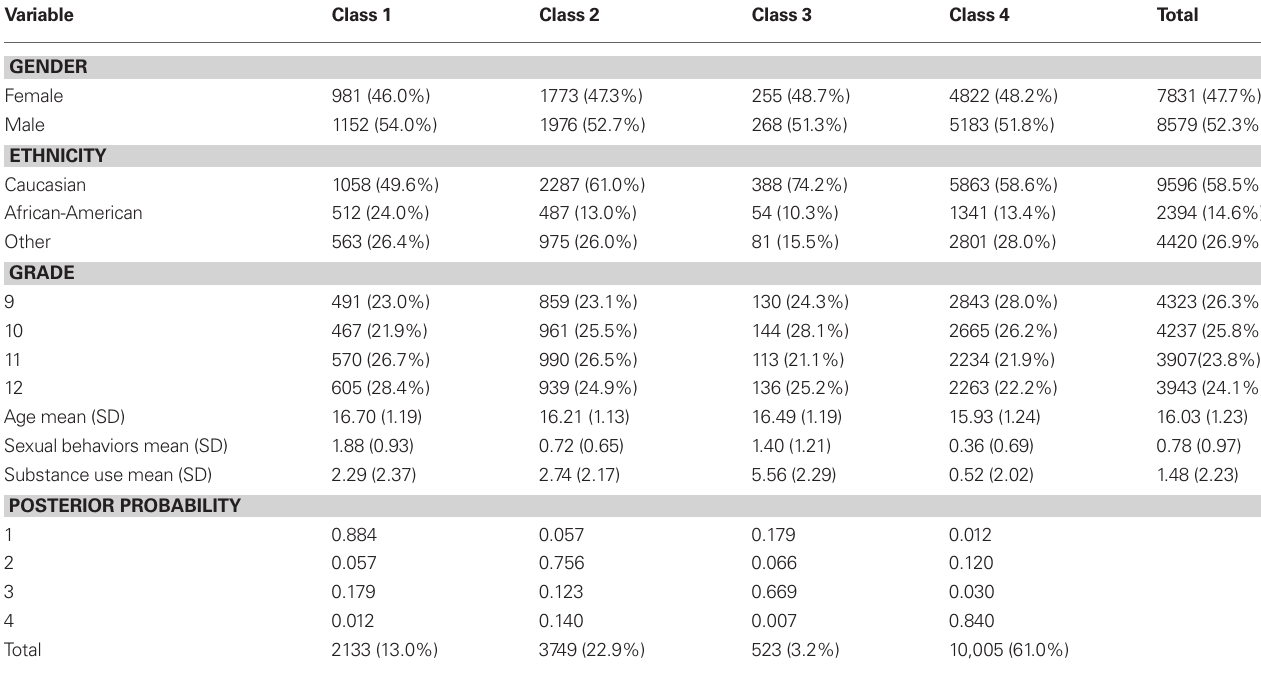
Table 2 | Descriptive statistics for total YRBS sample.